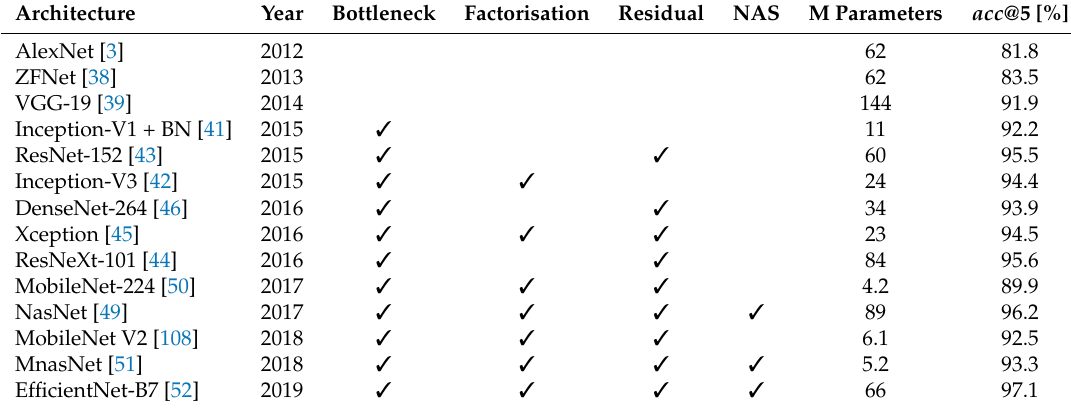
Table 2. Summary of the evolution of convolutional neural networks (CNNs) for image recognition. Bottleneck and Factorisation refer to the design concepts mainly developed in the Inception Family